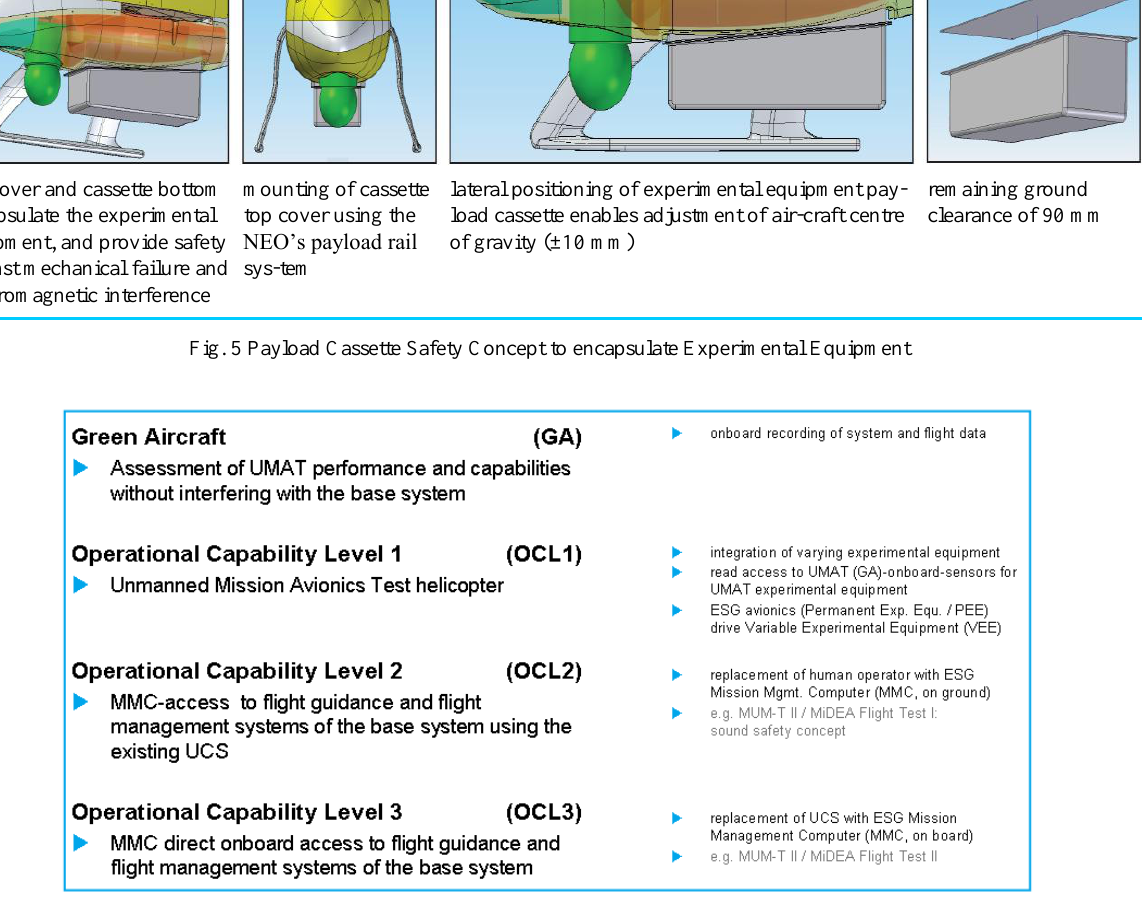
Fig. 6 UMAT levels of operational